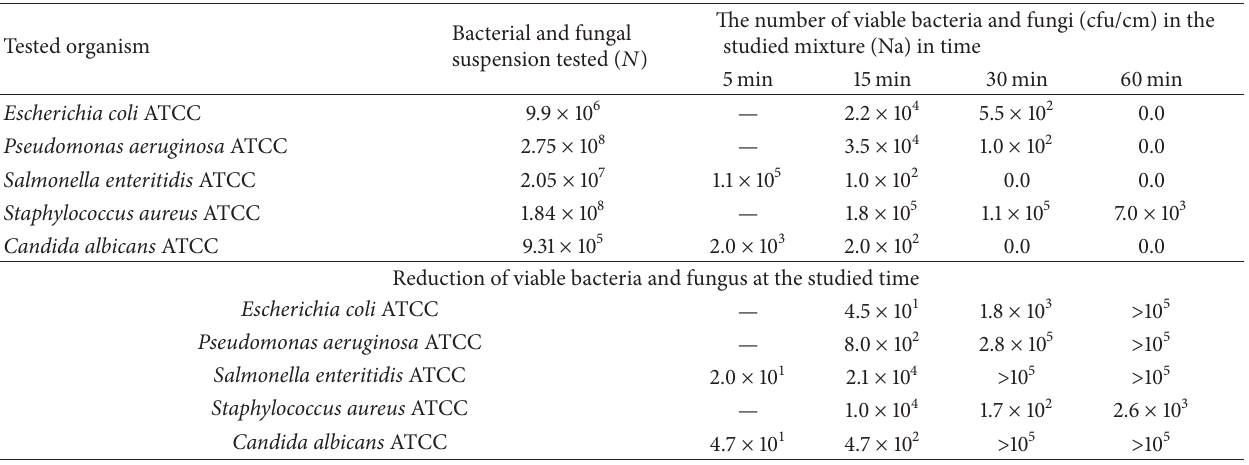
Table 7: Results of the evaluation using the dilution-neutralisation method for suspension number 7.